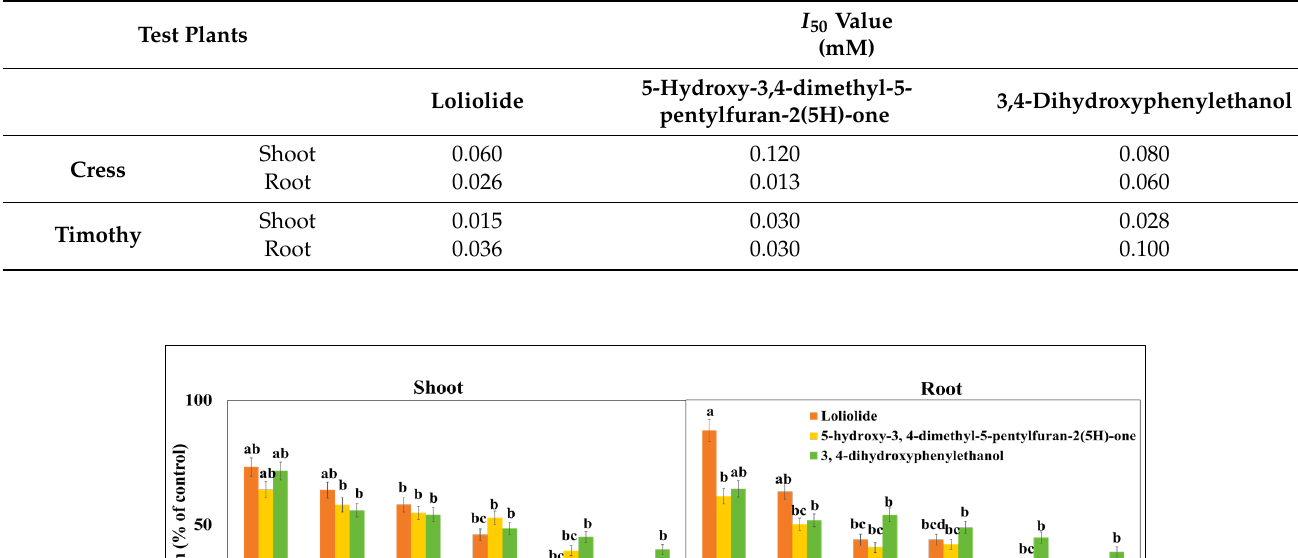
I 50 values of loliolide, 5-hydroxy-3,4-dimethyl-5-pentylfuran-2(5H)-one, and 3,4- dihydroxyphenylethanol characterized from A. reticulata leaf extracts for shoot and root growth inhibition of cress and timothy.